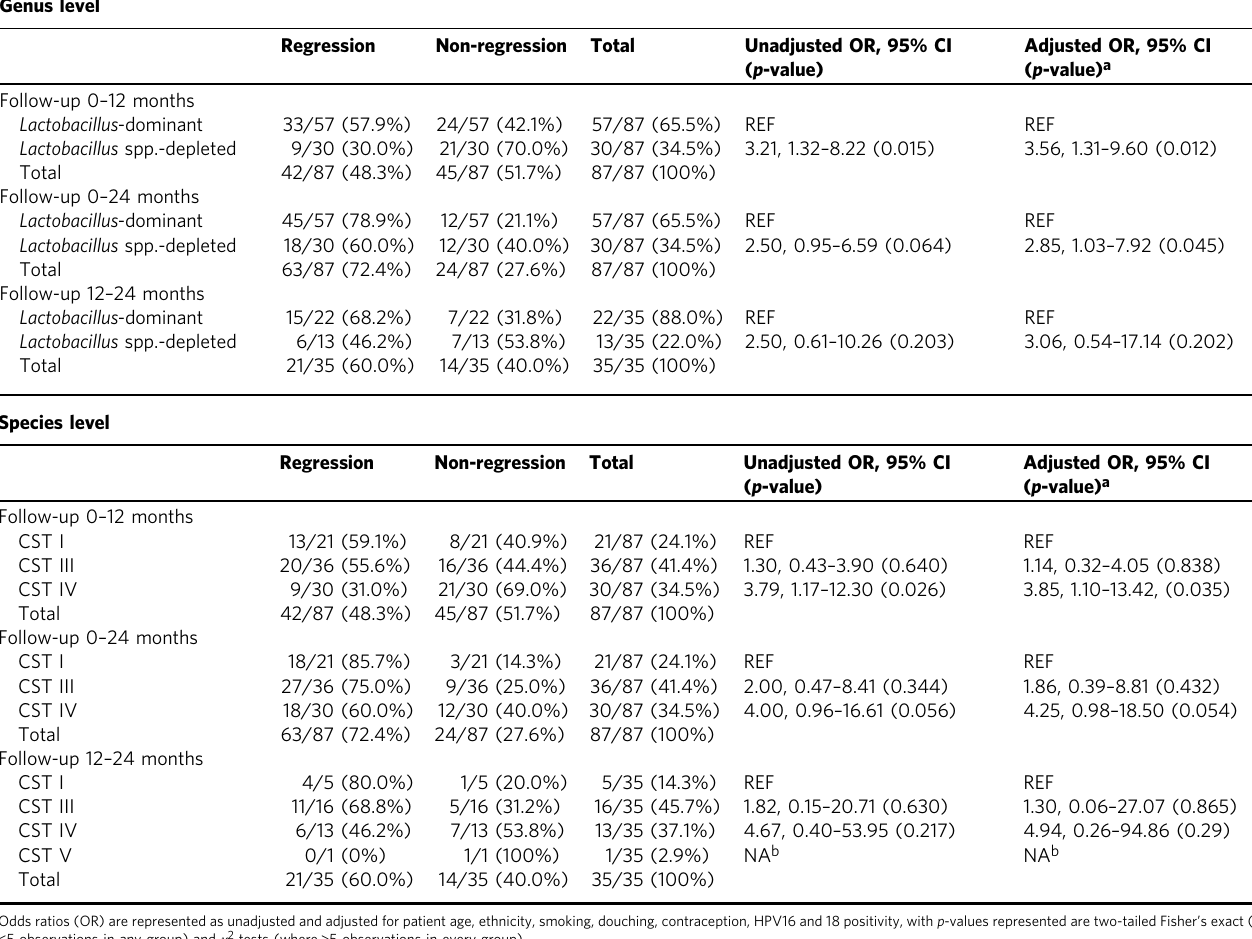
Table 2 Outcomes according to VMB composition at 12- and 24-month follow-up at genus and species level. Genus level